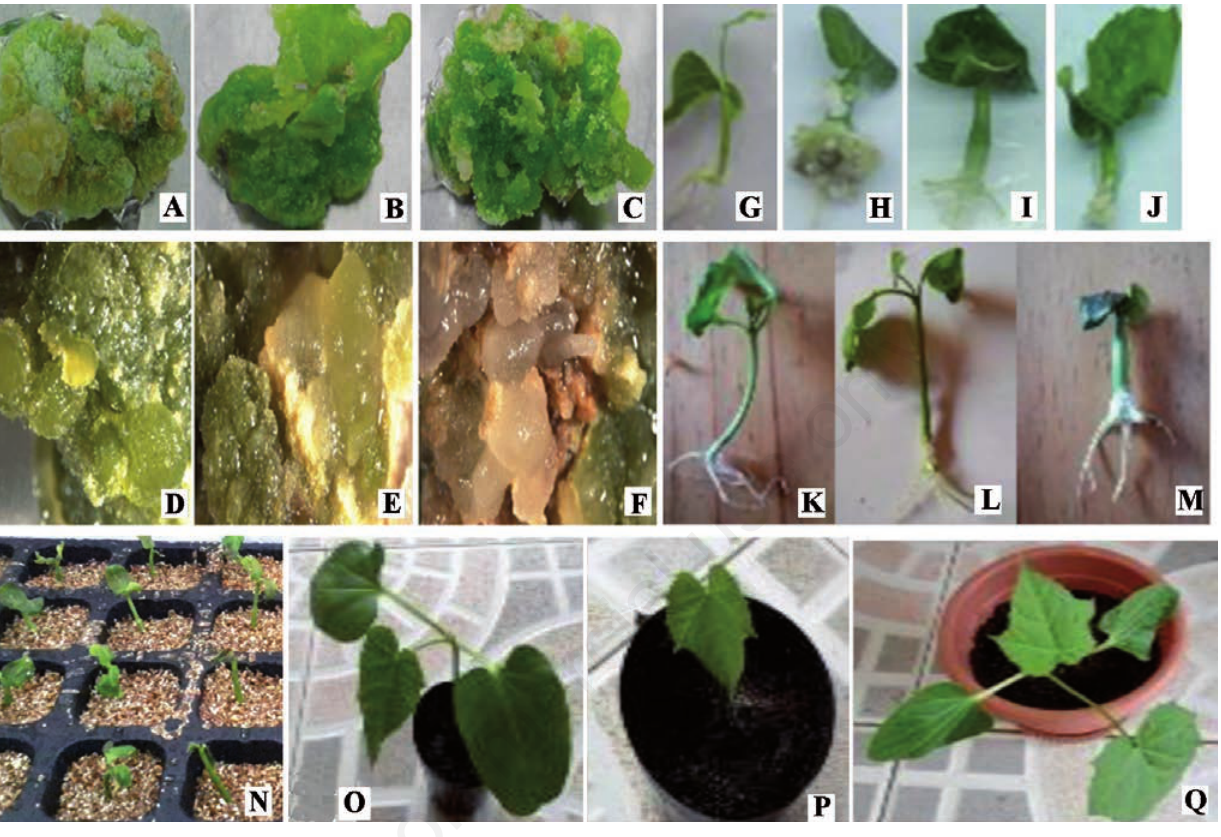
Figure 1. A-E) Morphological differences among calli of Jatropha carcas . A) T3; B) T6; C) T9; D) T7; E-F) T4. G-M) Morphology of the plantlets using either embryos or mature seeds as explants. G) MS only (embryo); H) MS+2,4-D (embryos); I) MS+BAP (embryos); J) MS+K (embryos); K) MS only (mature seeds); L) MS+K (mature seeds); M) MS+BAP (mature seeds). N-Q) Acclimatisation and transplantation. N) Acclimatisation in the small green house; O,P) plantlets transplanted after 2 weeks on 1.1 ratio of sand and soil; Q) fully regenerated plant.